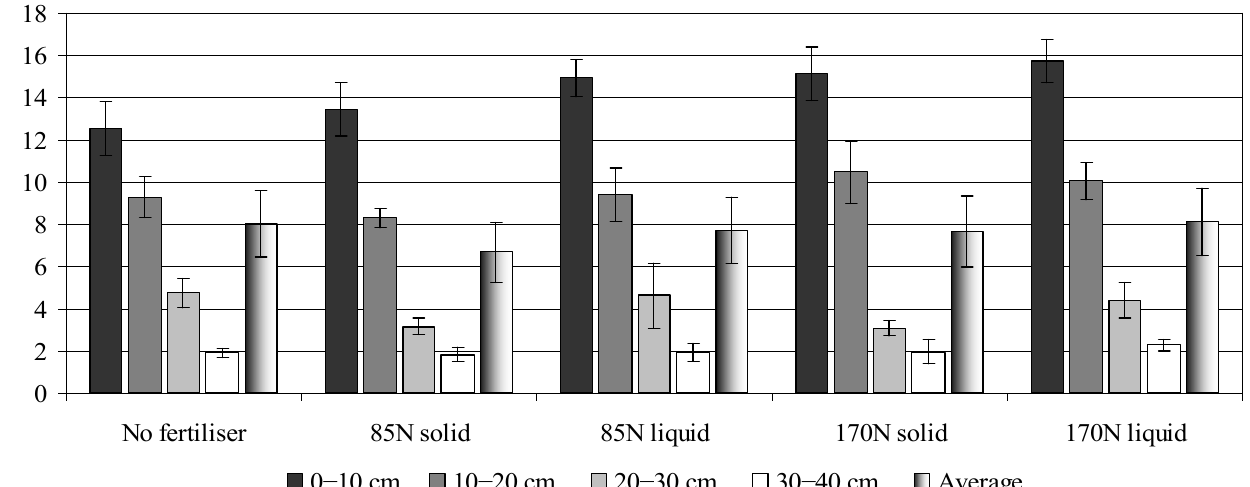
Figure 5. SOC content in grassland soil in Fluvisol, 2020 .